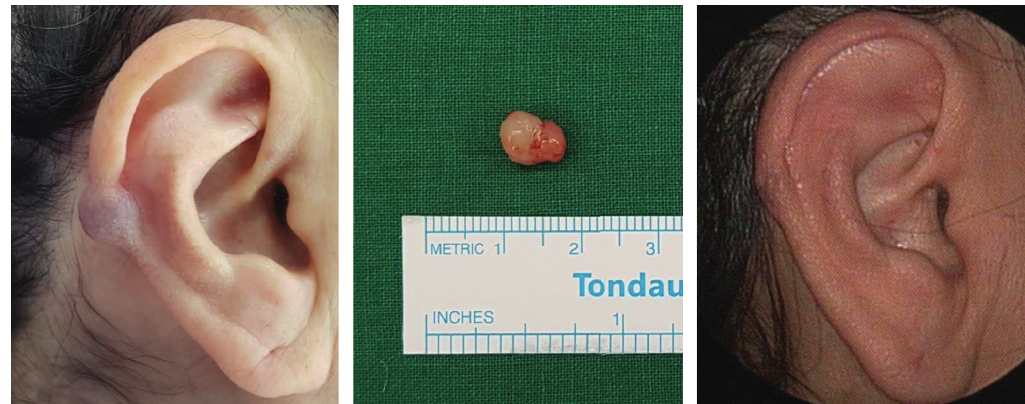
Figure 1: A soft and cystic mass with purple skin discoloration in the helix of the right auricle (a). Surgical specimen of the 0.8 × 0.6cm, whitish, soft, cystic mass (b). Postoperative wound which healed well after 2 months (c).